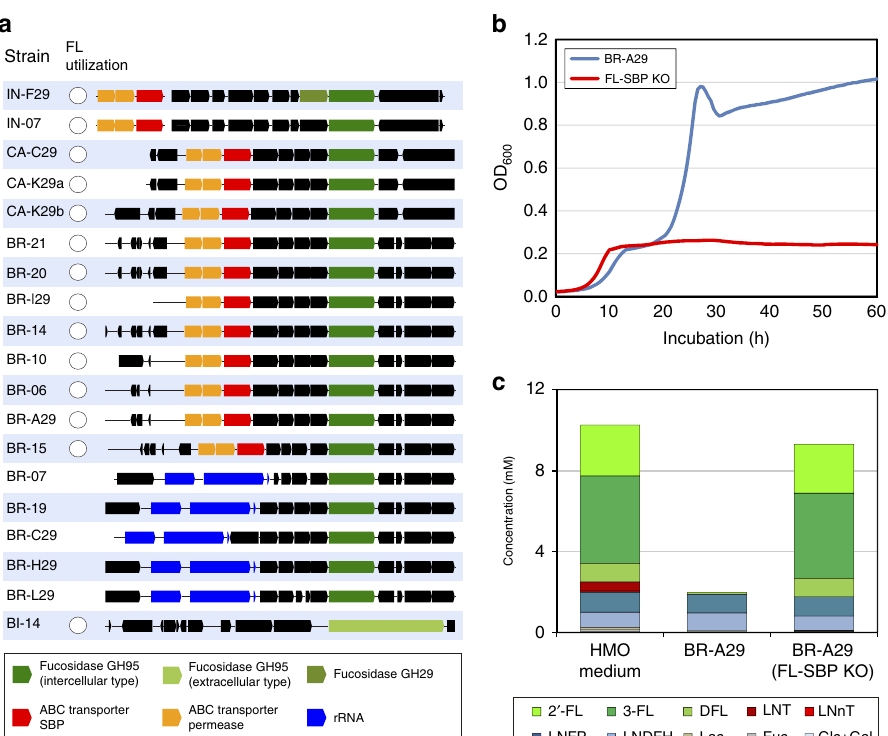
Figure 4 | Identification of bifidobacterial genes responsible for HMO utilization. ( a ) Syntenic relationships of putative FL-utilization gene clusters identified among the bifidobacteria. The genes and their orientations are depicted with arrows. Strains lacking fucosidase genes (10 strains among 29) are not represented. ( b ) Growth curves of the B. breve BR-A29 strain and the corresponding FL-SBP gene knockout strain in medium containing HMOs. ( c ) Glycoprofiles of BR-A29 and FL-SBP gene-knockout strains after 40h of cultivation.